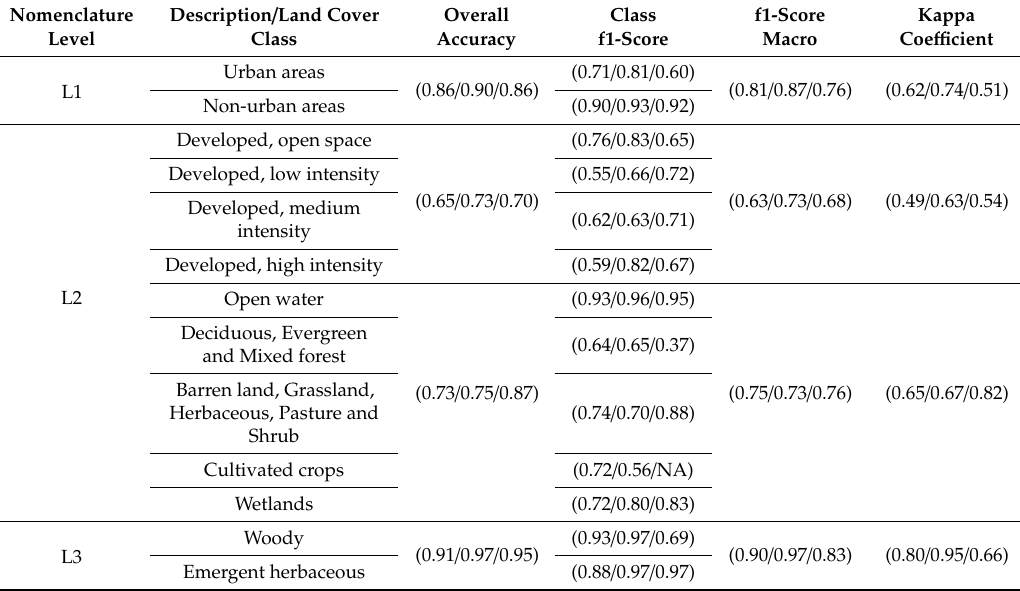
Table 7. Accuracy assessment of land cover classification (Weeks Bay / Savannah / Fire Island) during training and validation of the random forest